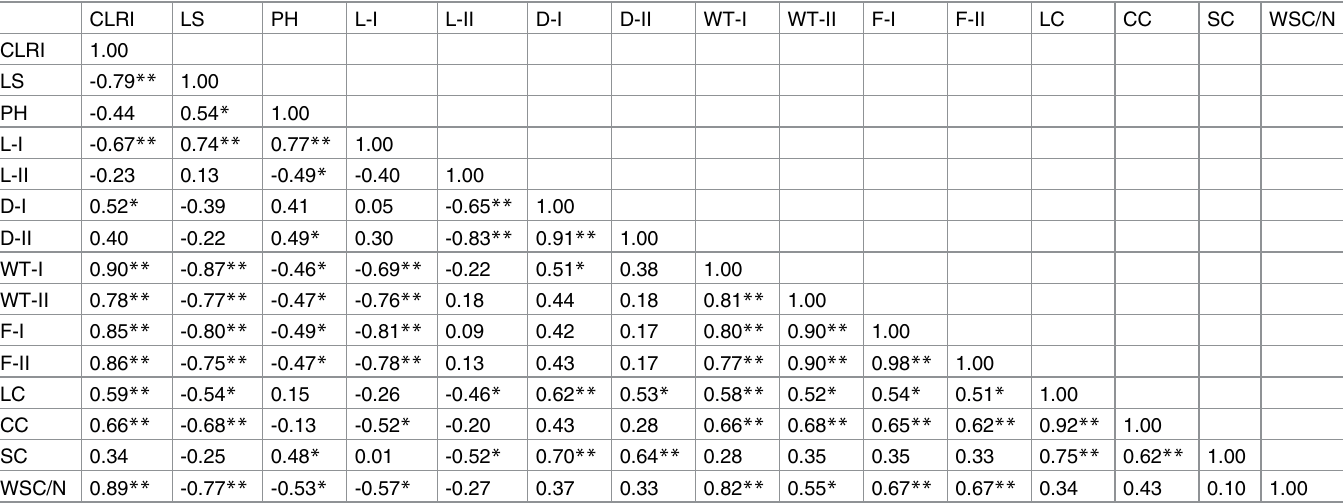
Table 6. Phenotypic correlations for culm lodging resistance index, lodging score and culm characters α .